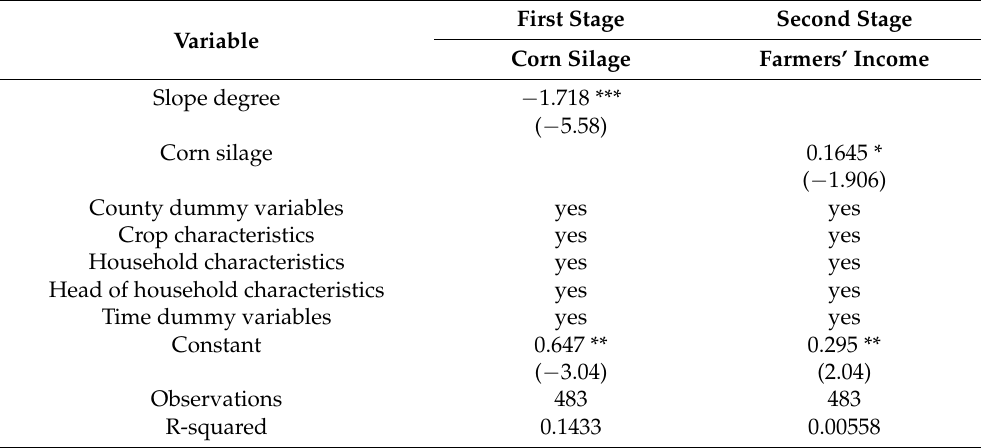
Table A1. The estimation results using topographic slope at the village-level as an instrumental